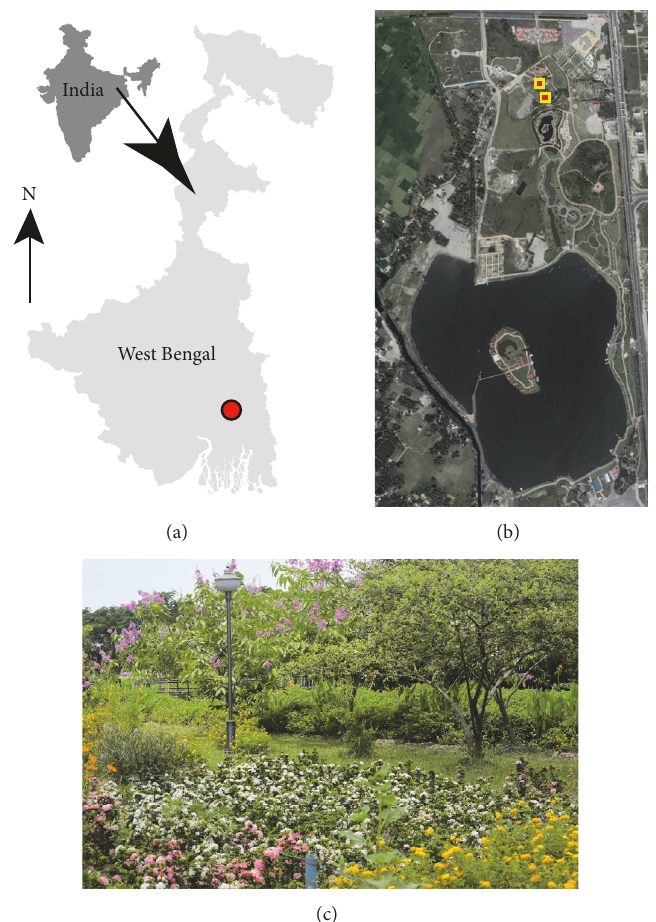
Figure 1: Location and surrounding habitat of intraspecific mating. (a) Location of Eco Park in West Bengal, India. (b) On the map, the red and yellow spots show the GPS taken for the observation of two occurrences (map courtesy: Google Earth, Google LLC.) . (c) Habitat of butterfly garden and presence of butterfly host plants and nectar